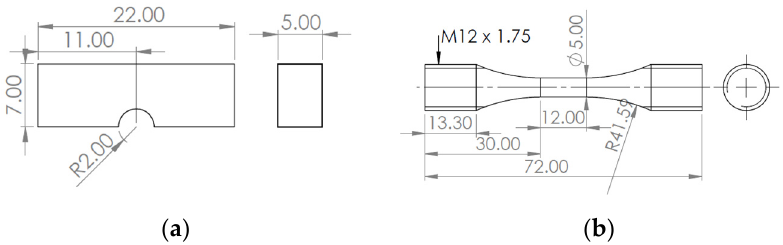
Figure 2. Fatigue specimens geometry and dimensions in mm: ( a ) Miniature bending [17]; ( b ) Stand- ard axisymmetric axial, adapted from [19].